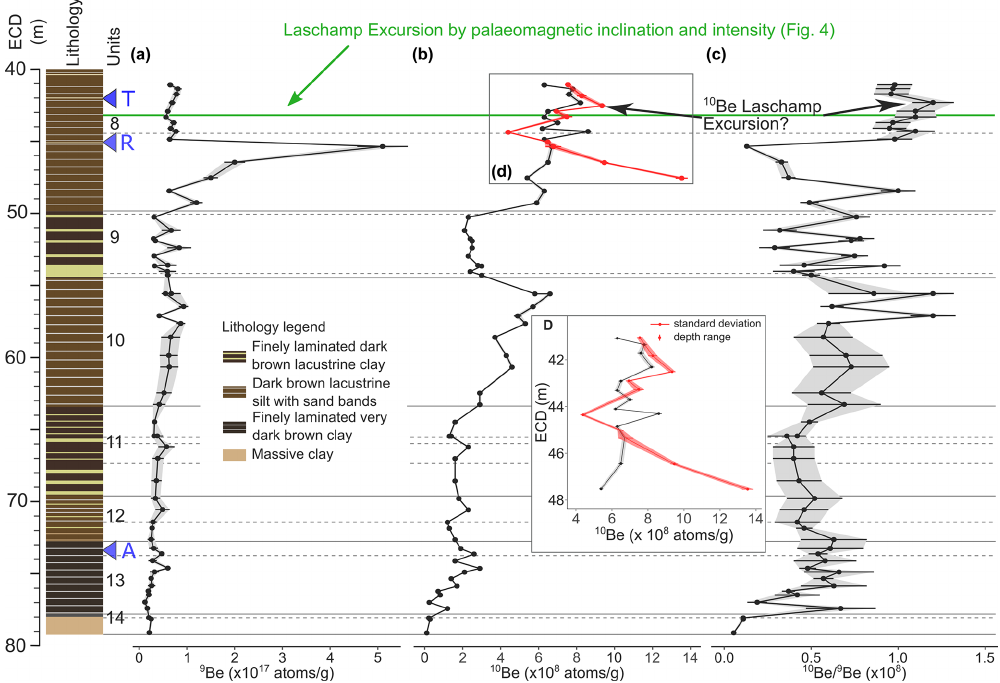
Figure 7. Beryllium variation in the lower ∼ 40m of the Orakei sediment sequence alongside the simplified lithology and facies unit boundaries (solid grey lines) and sub-unit boundaries (dashed grey lines) from Peti and Augustinus (2019). Green line marks the position of the Laschamp excursion according to the palaeomagnetic inclination and intensity (see Fig. 4 and Sect. 4.4). Blue triangles mark positions of the tephra marker layers T: Tahuna (38400 ± 1700 (2 σ )calyearsBP); R: Rotoehu (45100 ± 3300 (2 σ ) yearsBP); and A: “AVFaa” from Mt Albert (119200 ± 5600 (2 σ ) years). (a) 9 Be concentration ± 1 standard error. (b) 10 Be concentration ± 1 standard error from Lund (red) and ANSTO (black), enlarged interval in (d) . (c) 10 Be / 9 Be ratio ± 1 standard error. Grey and red shading highlight the uncertainty interval. Where error bars are not visible, they are within the size of the data